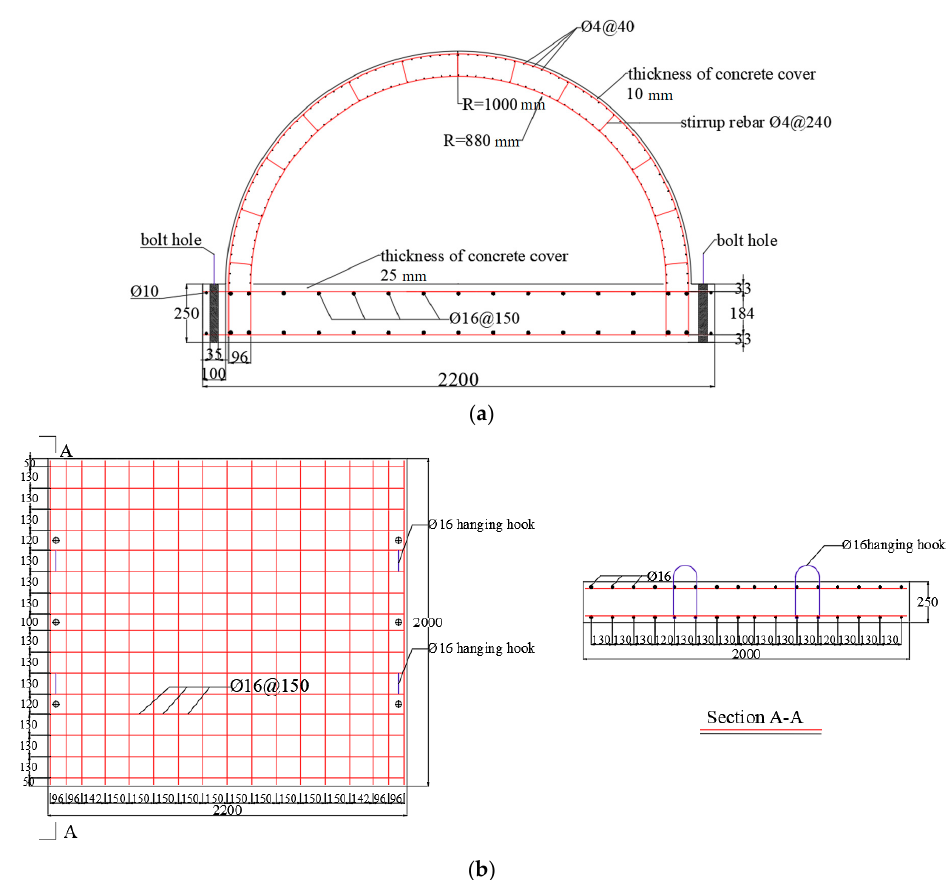
Figure 1. Geometrical dimensions and reinforcement of the specimen (unit: mm): ( a ) Tunnel; ( b ) Foundation slab .